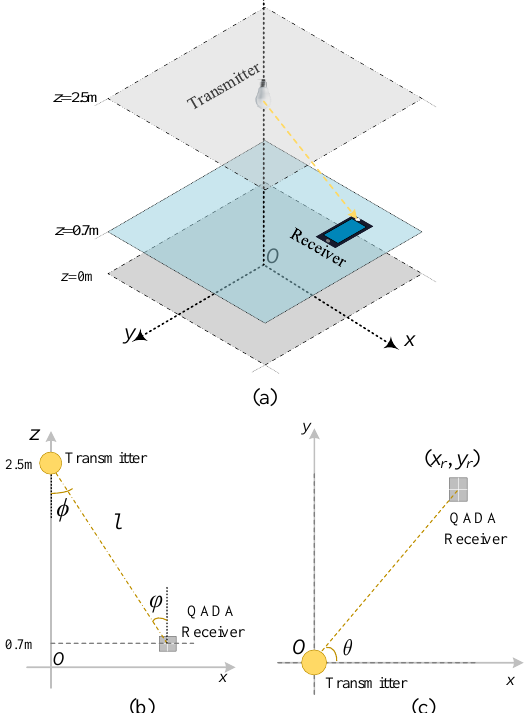
Figure 5. Communication system with a single transmitter at the center ( a ) a 3-D view of the configuration with a single transmitter and a QADA receiver; ( b ) a side view of the configuration; ( c ) a top view of the